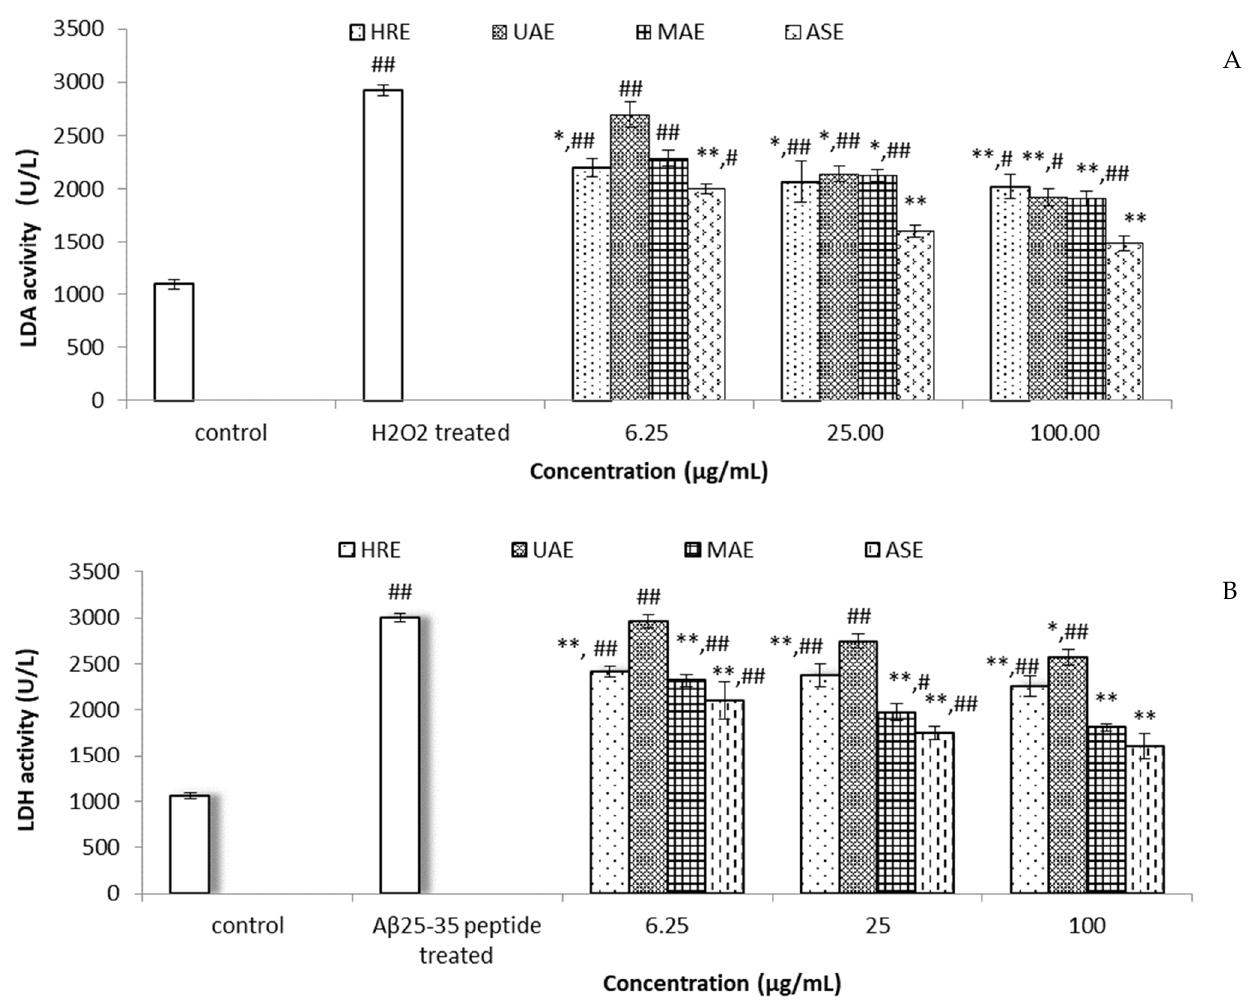
Figure 4. Effects of Gardeniae fructus extracts on the LDH release of ( A ) H 2 O 2 -induced or ( B ) A β 25–35 -treated PC12 cells. PC12 cells were pre-incubated with extracts (6.25, 25, and 100 µ g/mL) for 2 h (n = 4). Data are shown as means ± SD. # p < 0.01, ## p < 0.01 compared to control, * p < 0.05, ** p < 0.01 compared to H 2 O 2 - or A β 25–35 peptide-treated groups.